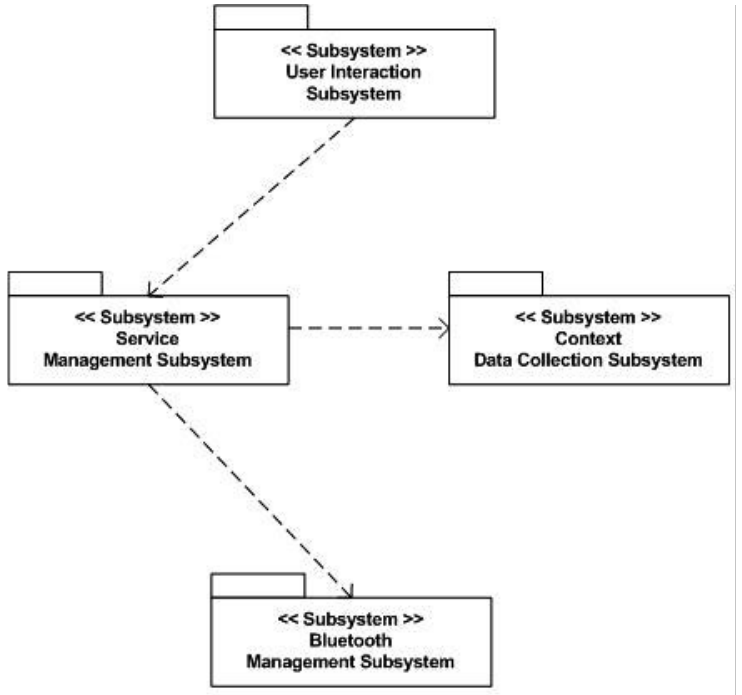
Figure 8. Subsystems diagram of our